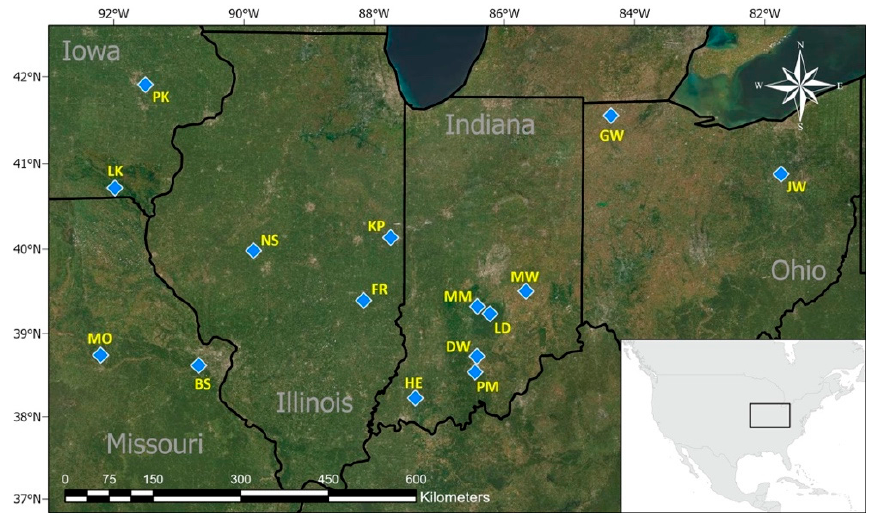
Figure 1. Map of the 15 study sites in the eastern US (blue square), where co-occurring Carya ovata and Quercus alba were sampled and analyzed. Site abbreviations are listed in Table